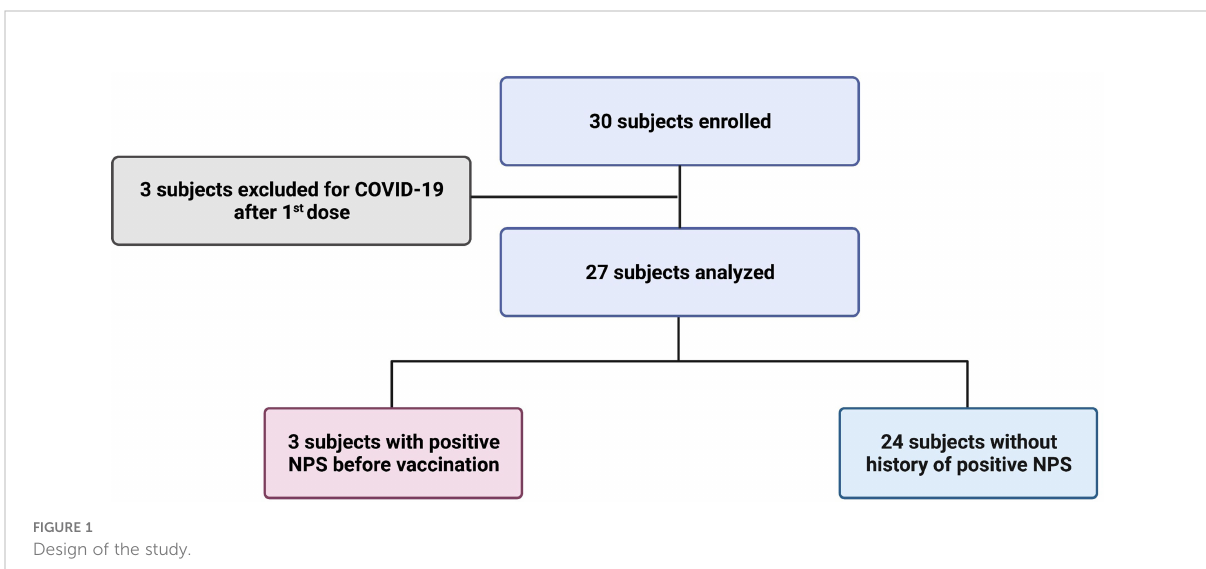
FIGURE 1 Design of the